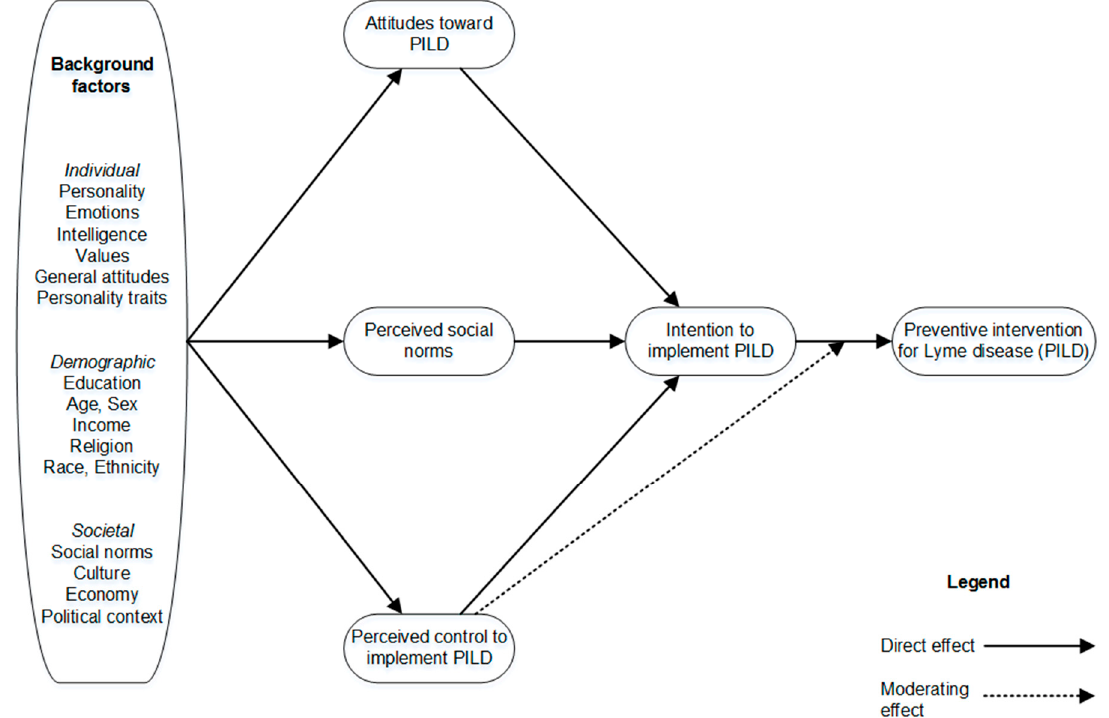
Figure 1. The theory of planned behavior model .